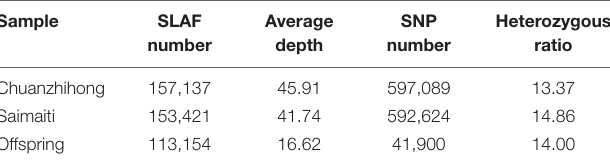
TABLE 2 | Number of specific-locus amplified fragment (SLAF) tags developed and SNPs statistics. Sample